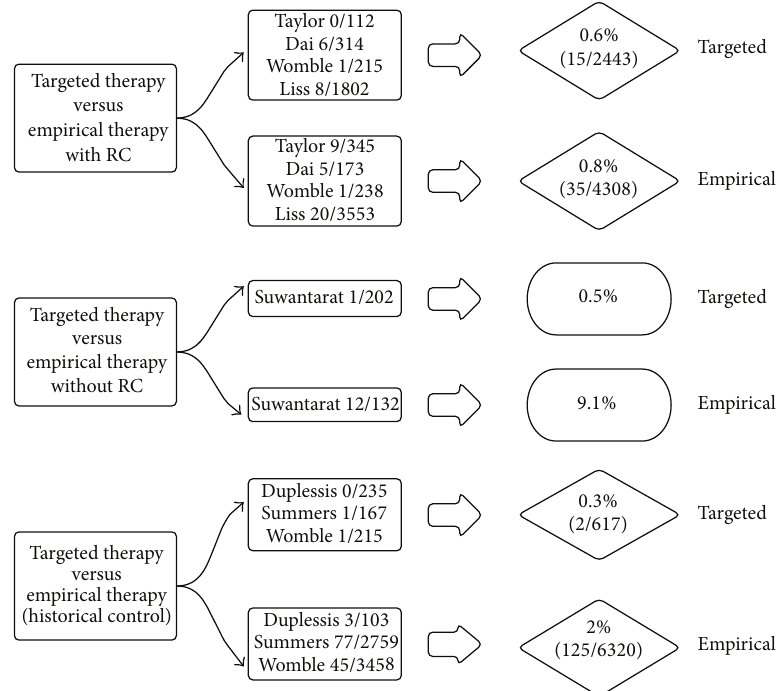
Figure 3: The risk of infectious complications after prostate biopsy in studies using targeted versus empirical antibiotic